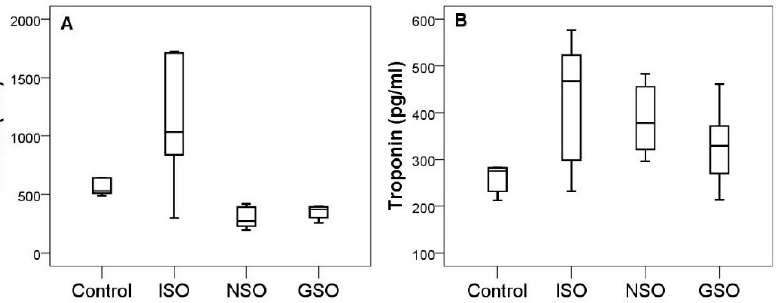
Figure 6. Serum levels of cardiac enzymes CK-MB ( A ) and troponin ( B ) in the experimental groups.